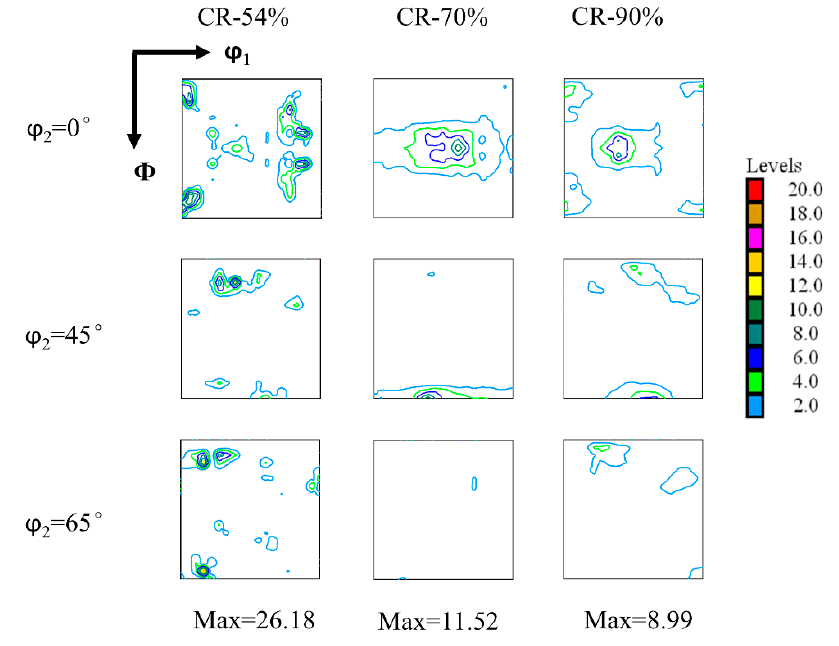
Figure 4. The sections ϕ 2 = 0°, 45°, 65° in the ODFs of Cu-0.1Al alloy under cross rolling.